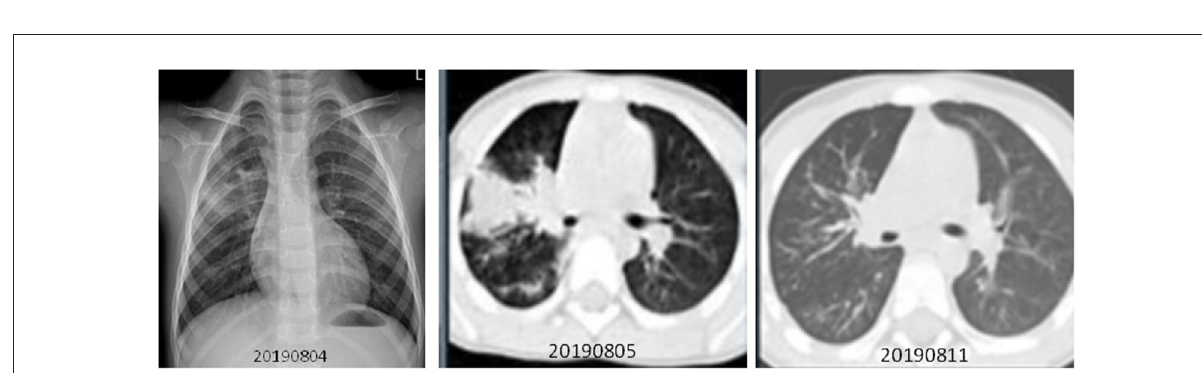
FIGURE5 Chest X-ray and CT scan were taken for a two-year-old boy with adenovirus and mycoplasma pneumoniae coinfection-induced fever on July 31, 2019. (1) (A) Left, Chest X-ray taken on August 4, 2019. Exudation and small patchy shadows in the upper lobe of the right lung. The right hilum shadow was slightly enlarged, and the left hilum was normal. No bilateral pleural effusion was observed. (2) (B) Middle, Chest CT plain scan was taken on August 5, 2019. Incomplete, segmental lung consolidation and exudation lesions were observed. Signs of air bronchogram were seen in the consolidation tissue, accompanied by segmental consolidation in the dorsal segment of the right lower lobe. The right hilar shadow was enlarged, and the left hilar was normal. There was no bilateral pleural effusion and no obvious enlarged lymph nodes in the mediastinum. (C) Right, Chest CT plain scan taken on August 11. The upper lobe of the right lung was redilated, showing upper, middle, and lower lobe bronchial wall thickening in the right lung as well as a weak patchy shadow distributed along the airway. There was no thickening of the lobular septum or pleura, and no pleural effusion was observed. The hilar had a normal morphology, and there was no significantly enlarged lymph node shadow in the mediastinum. Compared with the CT scans from the week prior, the right lung lesion had been significantly